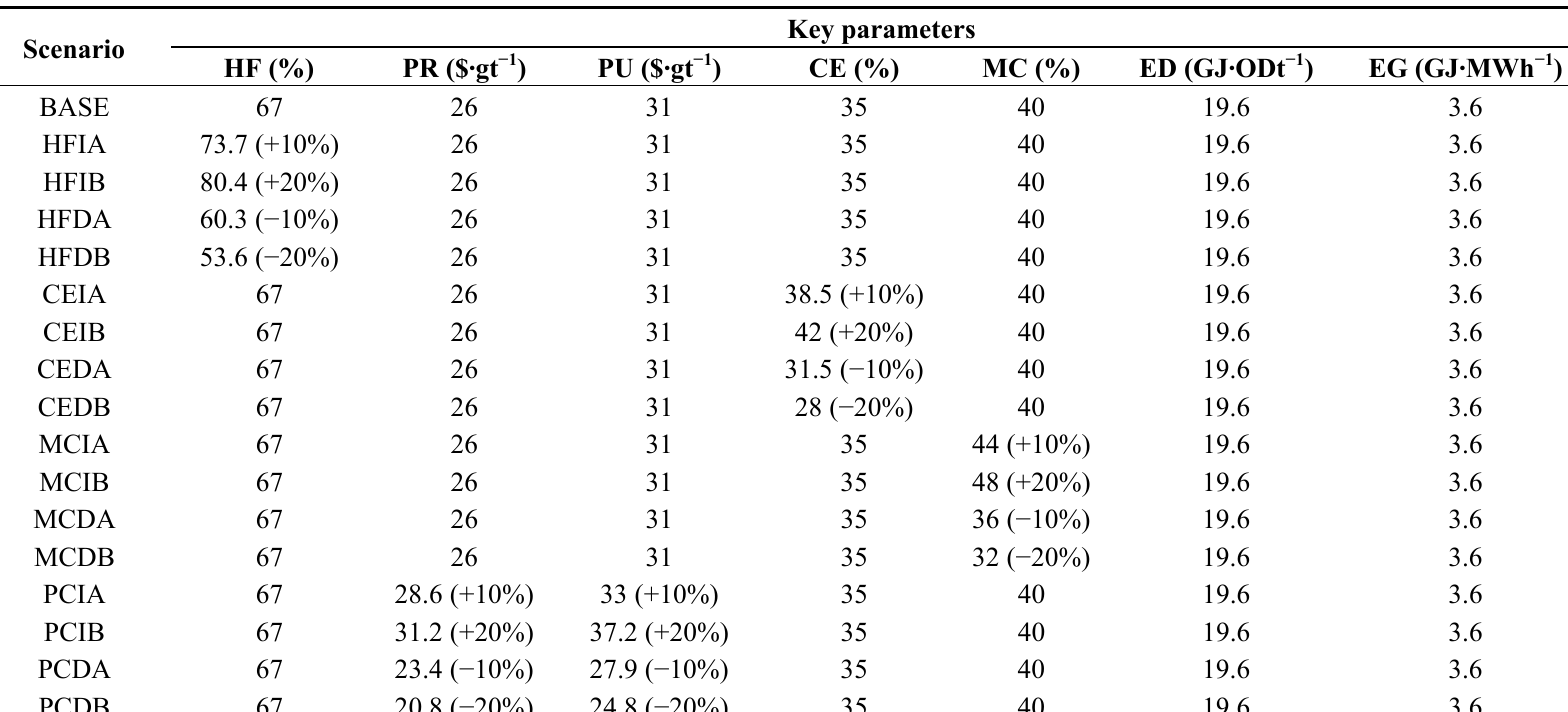
Table 2. Description of different scenarios of the model. Numbers in brackets indicate % change of parameters from the BASE scenario in sensitivity